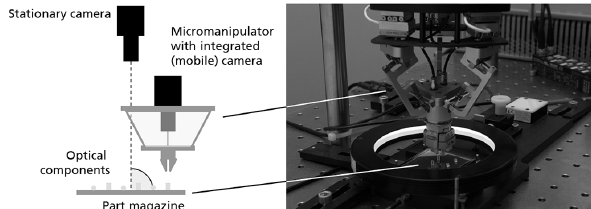
Figure 3. Model of the position and orientation of the stationary and mobile camera systems (left) and photography of the part mag- azine setup including dark field illumination using a ring light and the micromanipulator (right).